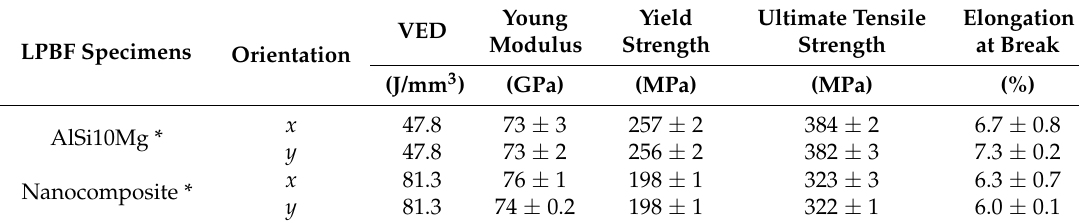
Figure 4. Stress ‐ strain curves for AlSi10Mg alloy and nanocomposite specimens built along the two different orientations. Table 4. Tensile properties obtained for AlSi10Mg and nanocomposite specimens built with different VED values in order to reach high densification levels, tested after a stress relieving treatment.